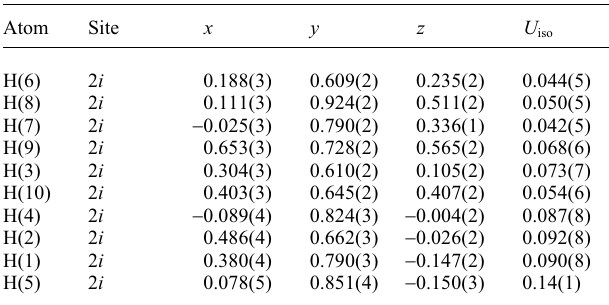
Table 1. Data collection and handling.